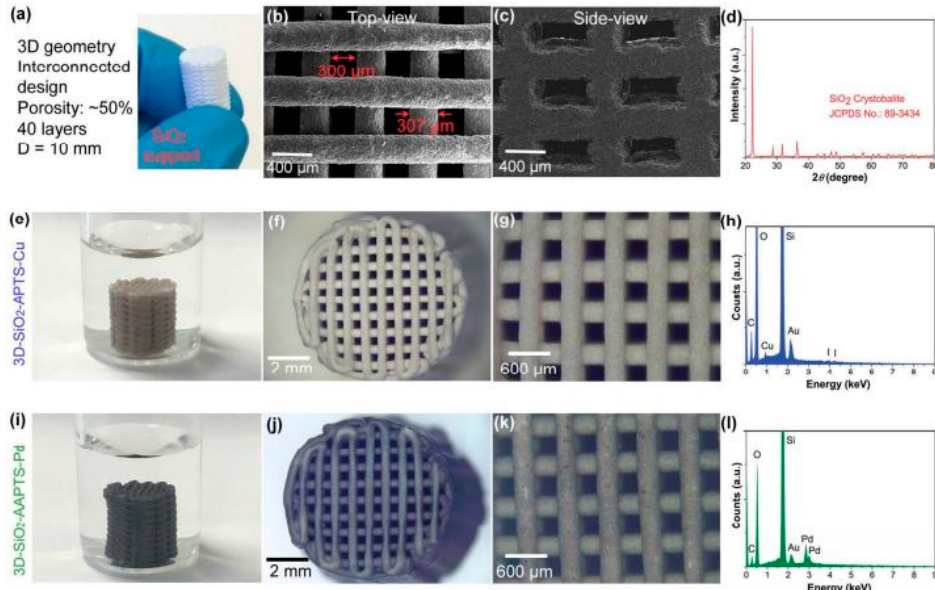
Figure 5. ( a ) SiO 2 wood pile structure. SiO 2 sintered structure scanning electron microscopy (SEM) images: ( b ) Top-view, ( c ) side-view and ( d ) X-ray diffraction XRD pattern. Optical images of the 3D-